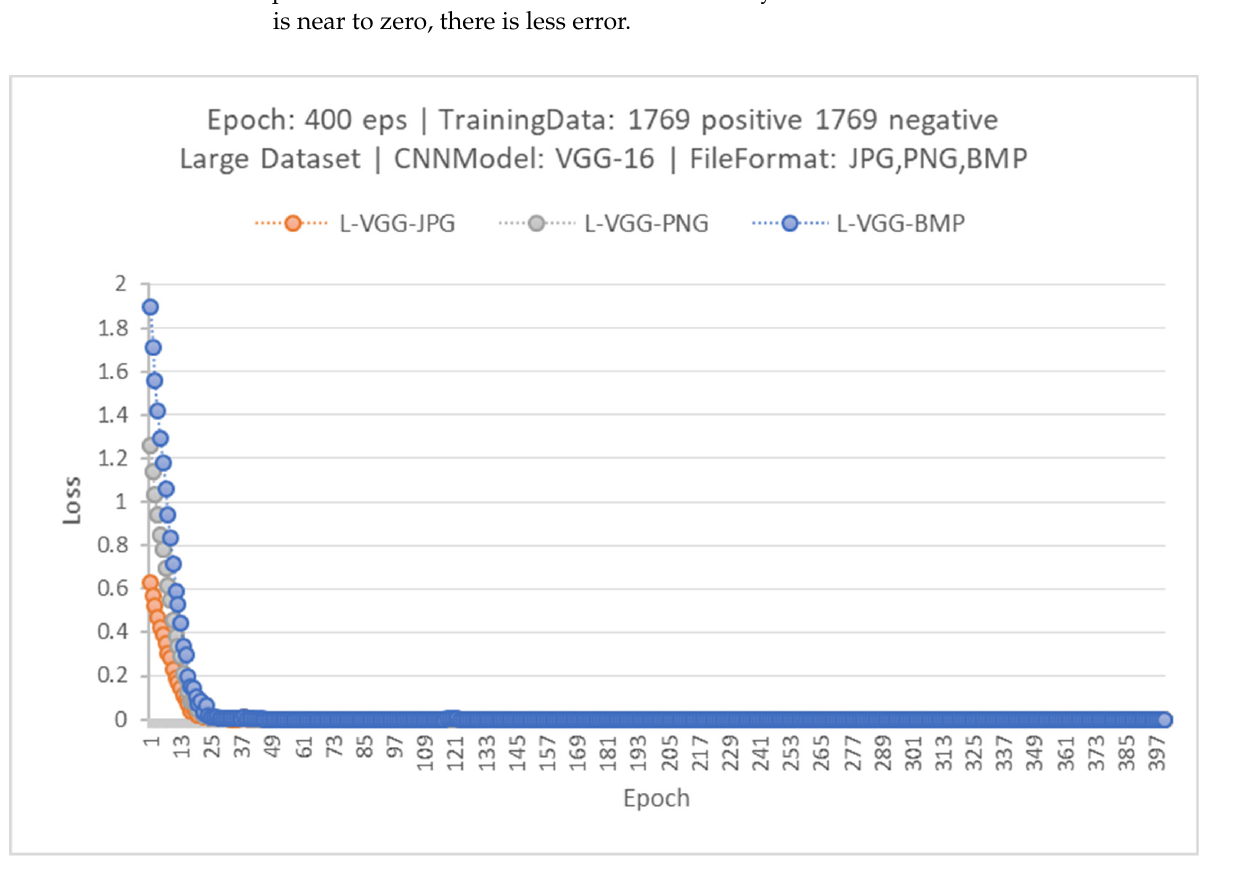
Figure 5. The loss of trained VGG-16 models. The one big concern for a radiologist or oncologist who trains the model in his hospital is when he should stop the training. In order to answer this question, the second experiment was conducted. In the second experiment, the CNN models were trained with more epochs in order to obtain the effect of epochs to loss values. Since VGG-16 models have the smallest loss value from the first experiment, only VGG-16 networks were continuously trained up to 2000 epochs. Then, the training graphs were recorded and divided into four training phases. In phase 1, loss values between 300 and 400 epochs were considered, as shown in Figure 6a. Loss values between 1000 and 1100 epochs, 1500 and 1600 epochs and 1900 and 2000 epochs were considered for phase 2, 3 and 4, respectively, as shown in Figure 6b–d. In each phase, the trendlines of losses vs. epochs were calculated and the slopes of the trendlines were collected. Table 3 shows the slope of all training